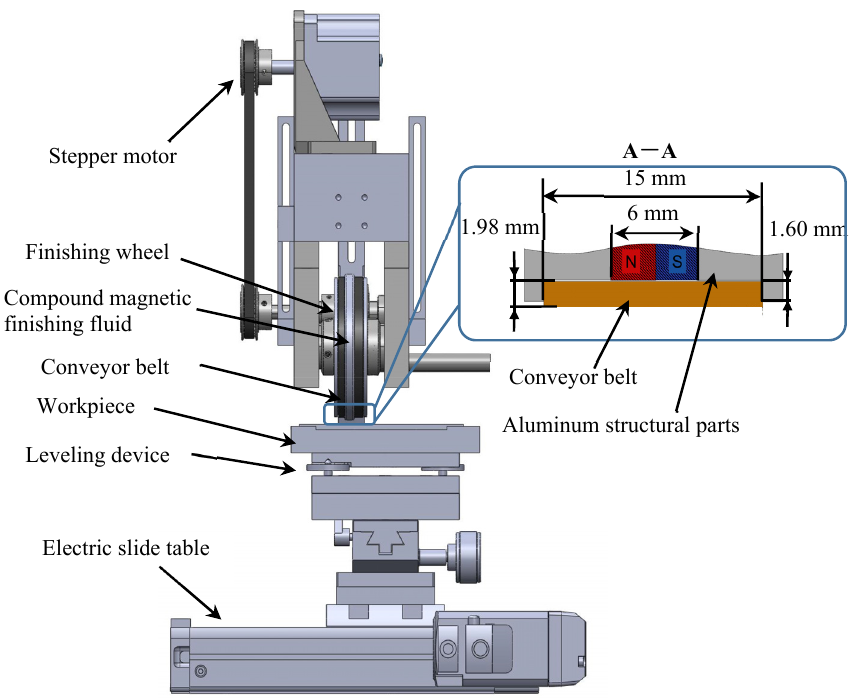
Figure 2. The schematic diagram of experimental device. Reprinted from Precision Engineering, 72, Xu J, Zou Y, Development of a new magnetic abrasive finishing process with renewable abra- sive particles using the circulatory system, Pages No. 417-425, Copyright (2021), with permission from Elsevier.